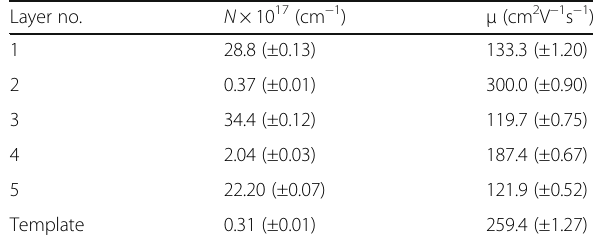
Table 2 Optically determined values of carrier concentration and mobility for each analyzed GaN layer of the investigated n + /n 0 /n + -GaN structure Layer